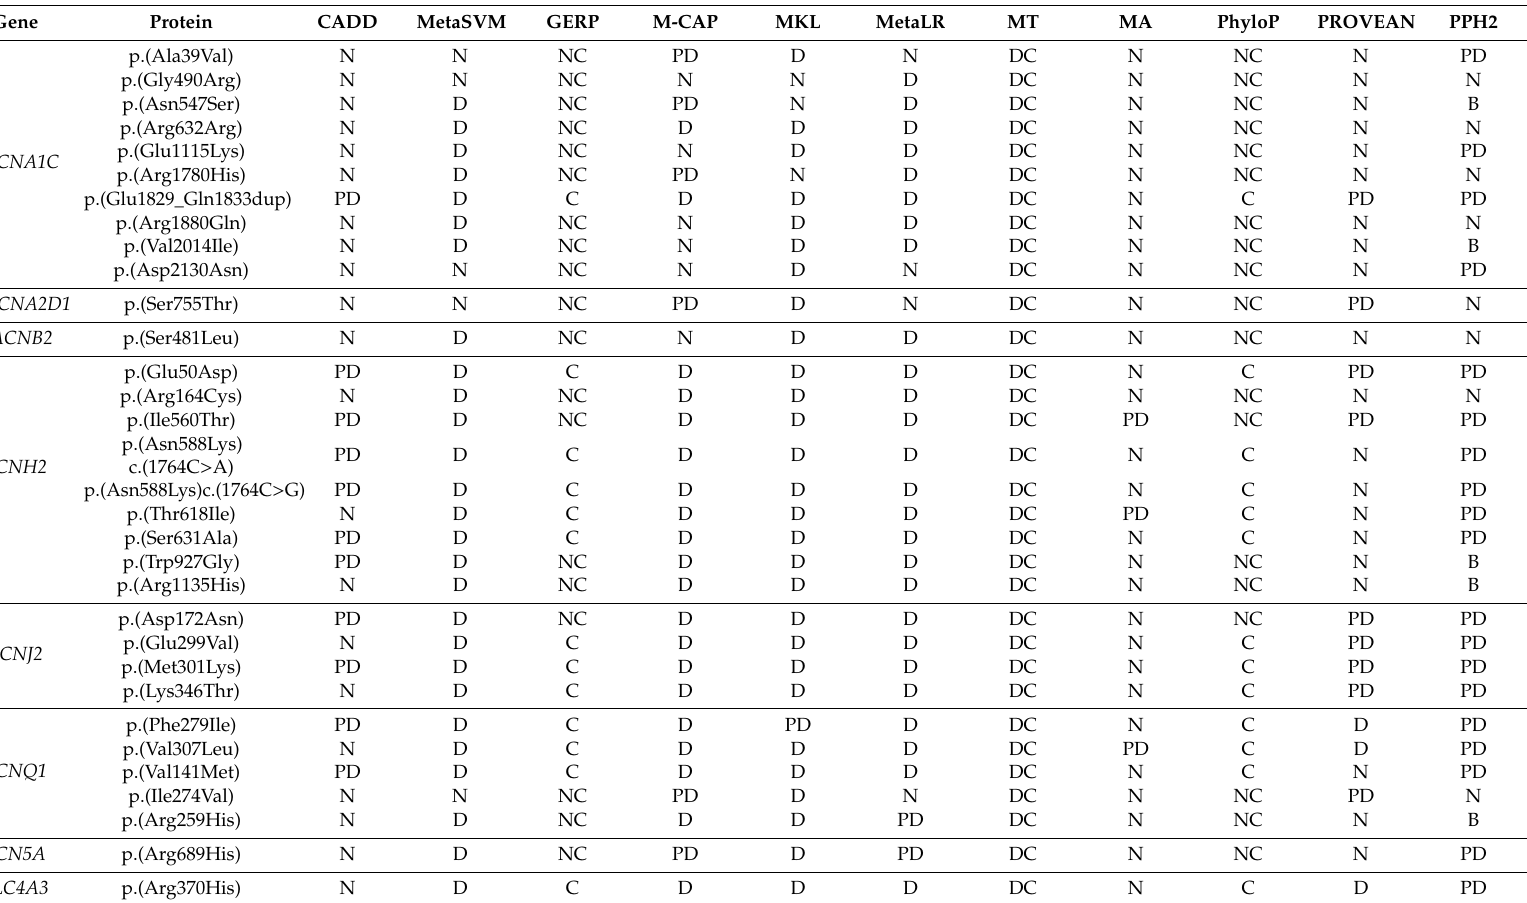
Classification in silico of variants. Combined Annotation Dependent Depletion -CADD-, Genomic Evolutionary Rate Profiling -GERP-, MetaSVM, Mendelian Clinically Applicable Pathogenicity Score -M-CAP-, Fathmm-MKL, MetaLR, Mutation Taster -MT-, Mutation Assessor -MA-, Phylogenetic Analysis -PhyloP-, Protein Variation E ff ect Analyzer -PROVEAN-, Polymorphism Phenotyping v2 -PolyPhen2, PPH2-, DC: Disease Causing, B: Benign, D: Deleterious / Damaging, PD: Probably Damaging / Deleterious, N: Neutral, C: Conserved aminoacid, NC: No conserved